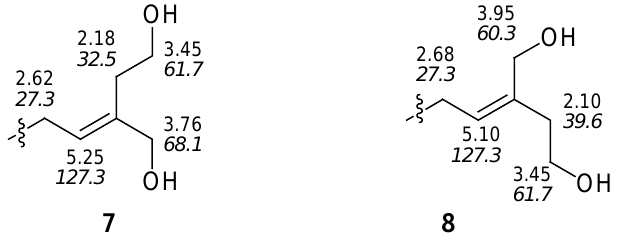
Figure 1 . Selected 1 H- and 13 C-NMR values for compounds 7 (3 E -isomer) and 8 (3 Z